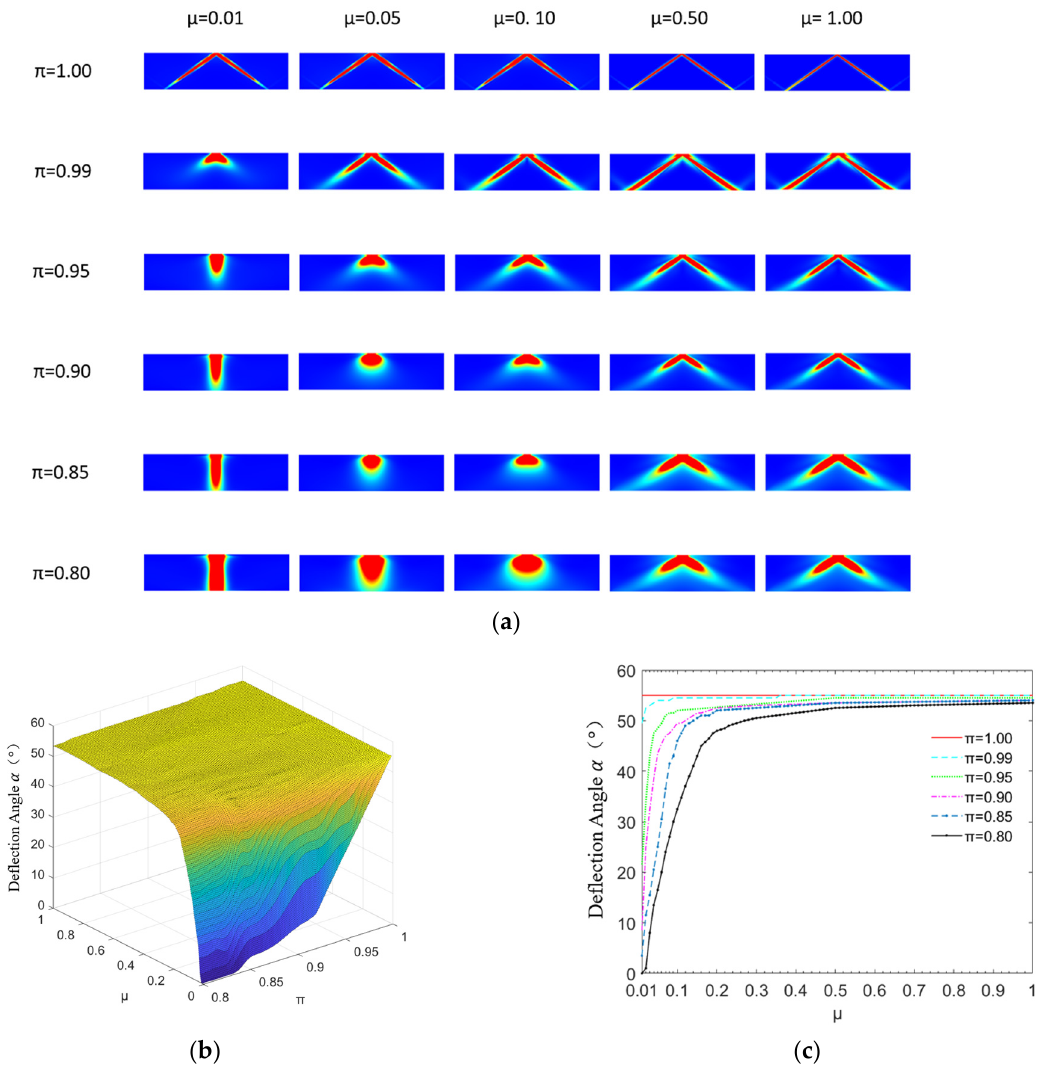
Figure 14. Relationship between pentamode characteristic parameters and the deflection angle of the energy-flow vector. ( a ) Energy-flow characteristics of a rectangular material; ( b ) relationship curves between pentamode characteristic parameters and the deflection angle of the energy-flow vector; and ( c ) relationship curve transversal.